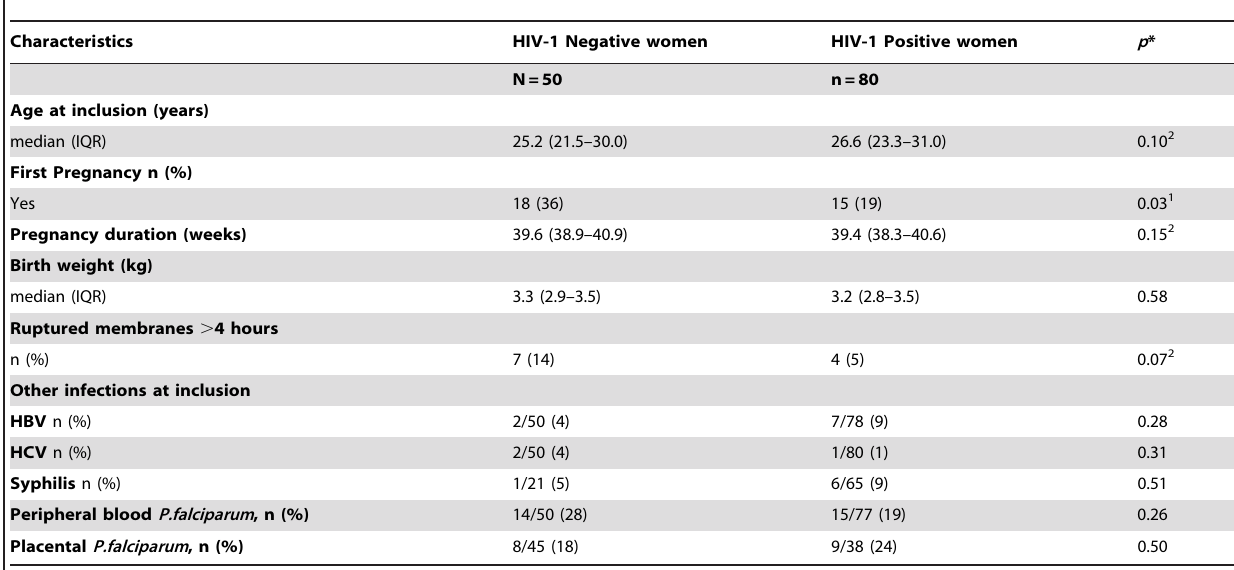
Table 1. General characteristics of the women recruited in the study.